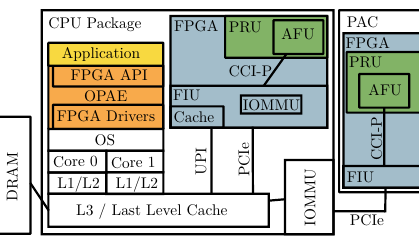
Figure 1: Overview of the architecture of Intel FPGAs. The software part of the Intel Acceleration Stack called OPAE is highlighted in orange. Its API is used by applications (yellow) to communicate with the AFU. The Green Region marks the part of the FPGA that is re-configurable from userspace at runtime. The Blue Region describes the static soft core of the FPGA. It exposes the CCI-P interface to the